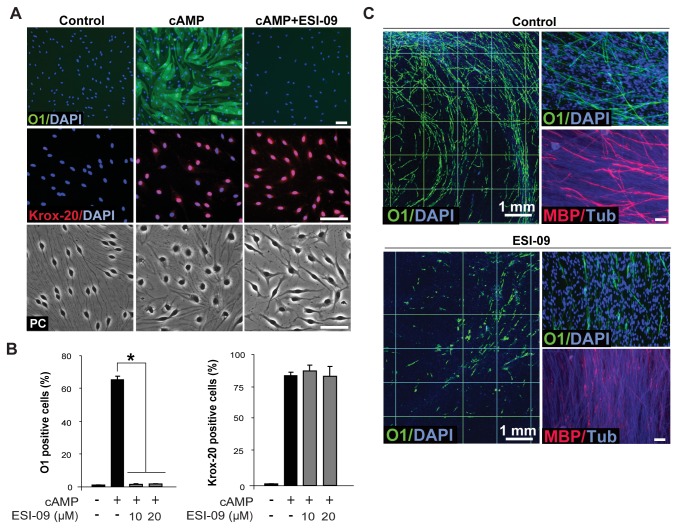
Antagonistic action of the EPAC inhibitor, ESI-09, on cAMP-induced SC differentiation and myelin sheath formation.Differentiation (A-B) and myelination (C) assays were performed and analyzed essentially as described in previous figures. Cultures were incubated with the indicated concentrations (B) or 20 µM of ESI-09 (A, C) during the whole time course of the experiments, i.e. 3 days (A-B) and 10 days (C), respectively. ESI-09 prevented the expression of O1 (A-B) and the morphological transformation that occurs in response to cAMP (CPT-cAMP, 250 µM), as revealed by the phase contrast (PC) image shown in A (bottom panel). However, ESI-09 did not prevent the expression and nuclear localization of Krox-20 (A, middle panel, and B, right panel). In C, note the dramatic reduction in the number and distribution of O1 positive and MBP positive SCs in ESI-09-treated cultures.